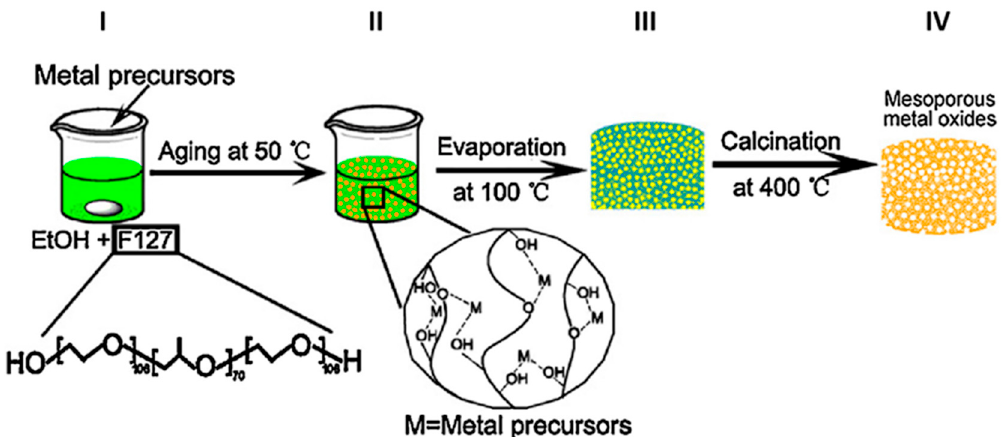
Figure 1. General synthetic scheme for the production of mesoporous metal oxides according to the evaporation-induced self-assembly method (EISA). The first step consists in the preparation of an ethanol solution containing the metal precursor (Ti(OBu) 4 for TiO 2 ) and the Pluronic F127 as templating agent ( I ). The mixture is kept at 50 °C for 24 h in order to induce the coordination bonds between the metal ions (M) and oxygen-containing group of F 127 ( II ). The subsequent thermal treatment at 100 °C for 6 h ( III ) promotes the formation of a xerogel of the metal-F127 hybrids. The final calcination at 400 °C ( IV ) is intended to remove of organic molecule and results in the formation of mesoporous metal oxides. Reprinted with the permission of ref. [33]. Copyright © 2019 4542370045937.